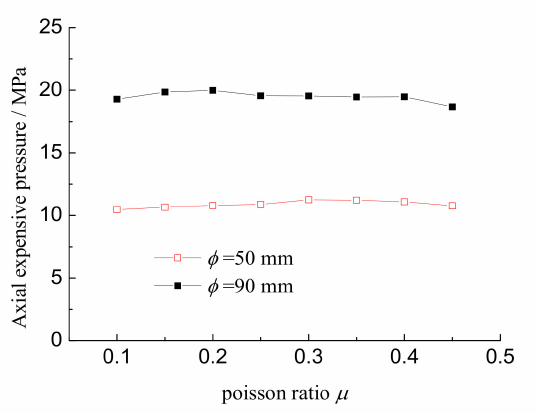
Figure 10. Relationship between Poisson’s ratio and axial expansive